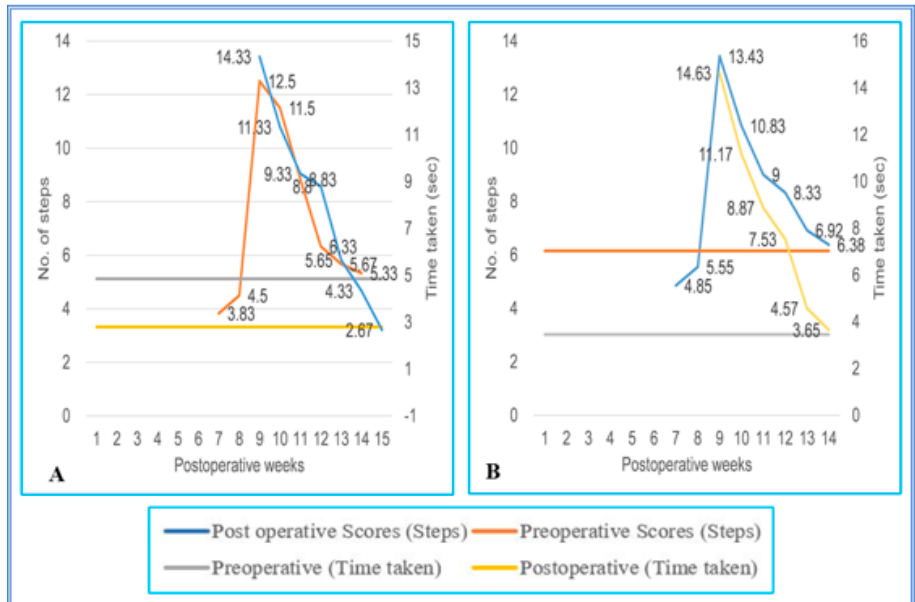
Figure 5. ( A , B ) Evaluation of locomotor behavior in staircase test after SPC hemisection in Bonnet monkey ( Macaca radiata ) on staircase runway. X-axis represents duration of recovery of locomotor functions in terms of weeks; primary Y-axis and secondary Y-axis represent the number of steps and time taken by the spinal cord unilateral hemisection plus predegenerated peripheral nerve transplantation monkeys to climb up/down the staircase.